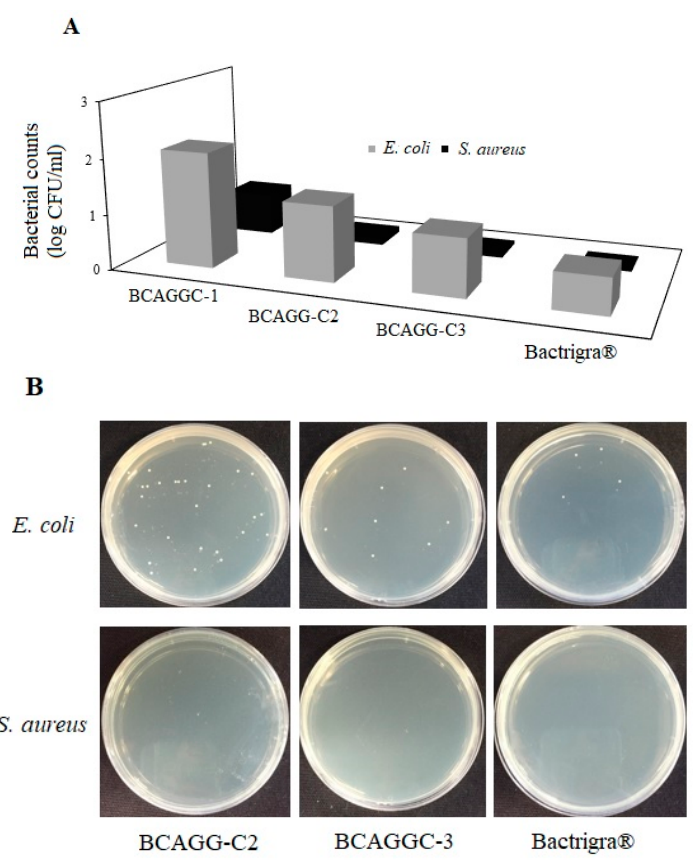
Figure 8. ( A ) Number of viable bacteria cells on the sample surface; and ( B ), agar plates of E. coli and S. aureus colonies at 48 h incubation on BCAGG-C2, BCAGG-C3 and Bactrigra®. S. aureus colonies at 48 h incubation on BCAGG-C2, BCAGG-C3 and Bactrigra